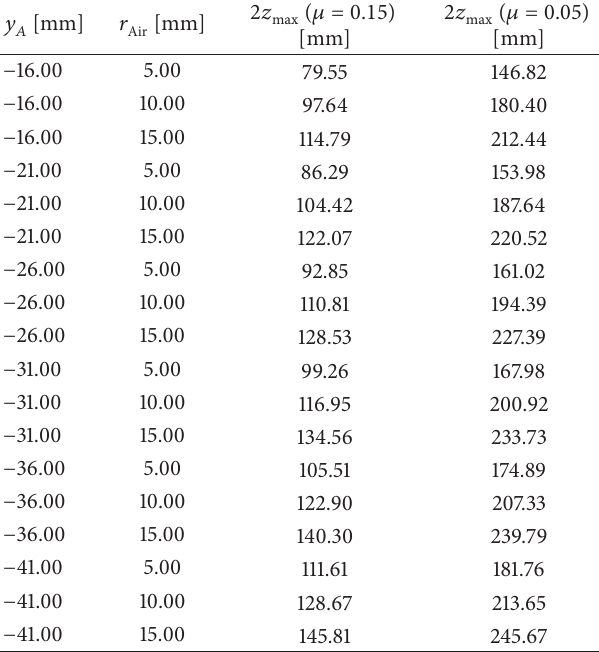
Table 4: The values of 𝑧 max . The transmittance of 10mm thick water layer is 80%.